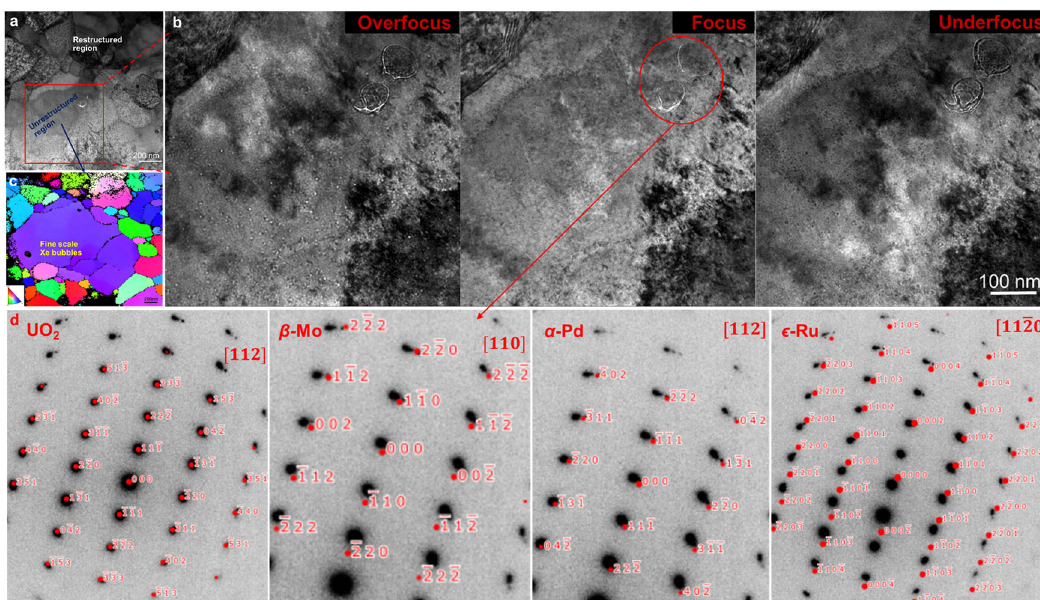
Fig. 2 Conventional approach to determine the crystal structure of fi ssion-product precipitates and Xe bubbles. a BFSTEM shows the microstructure of the transition region of the Limerick fuel. b Conventional TEM using the Fresnel contrast method can image the Xe bubbles but requires a longer time of operation. c A TKD map con fi rms the combination of both unrestructured (purple) grains and its surrounding submicron restructured grains, whereas only nanoscale Xe bubbles exist in the unrestructured grain. d SAED patterns show the matrix UO 2 on zone axis 112. The minor diffraction spots are dif fi cult to index because of the unknown structure of the small metallic fi ssion-product precipitates (<70 nm). Examples were given to fi t possible phases from literature 25,53,54 : BCC β -Mo (Tc, Ru ) on zone axis 110, FCC α -Pd (Ru, Rh ) on zone axis 112, and HCP ϵ -Ru (Mo, Tc, Rh, Pd) on zone axis 11 (cid:1)